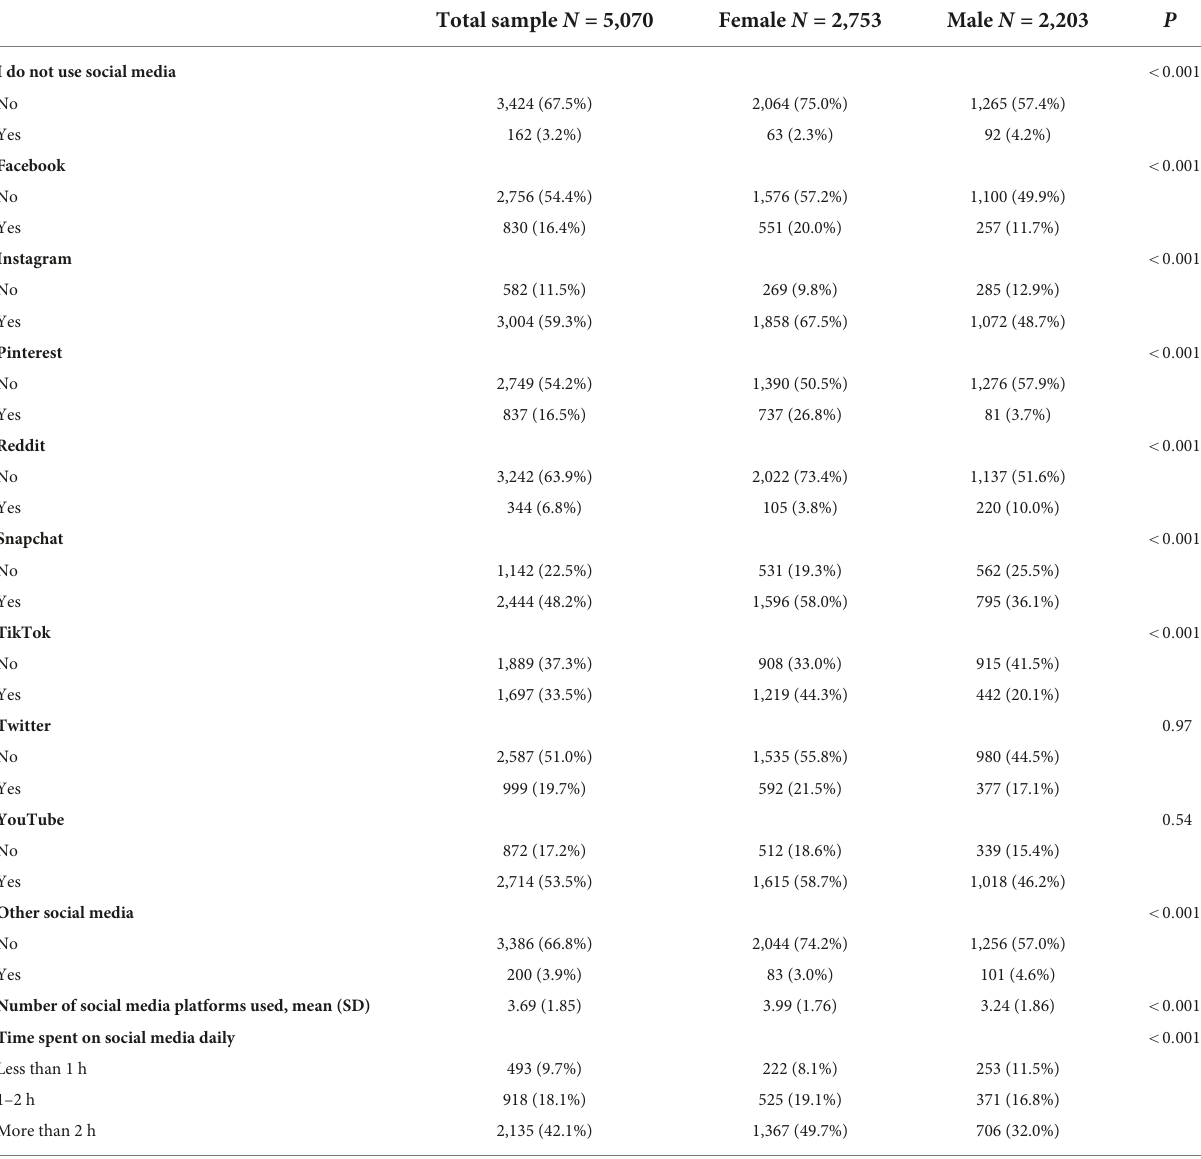
TABLE 1 Differences in social media (SM) use by